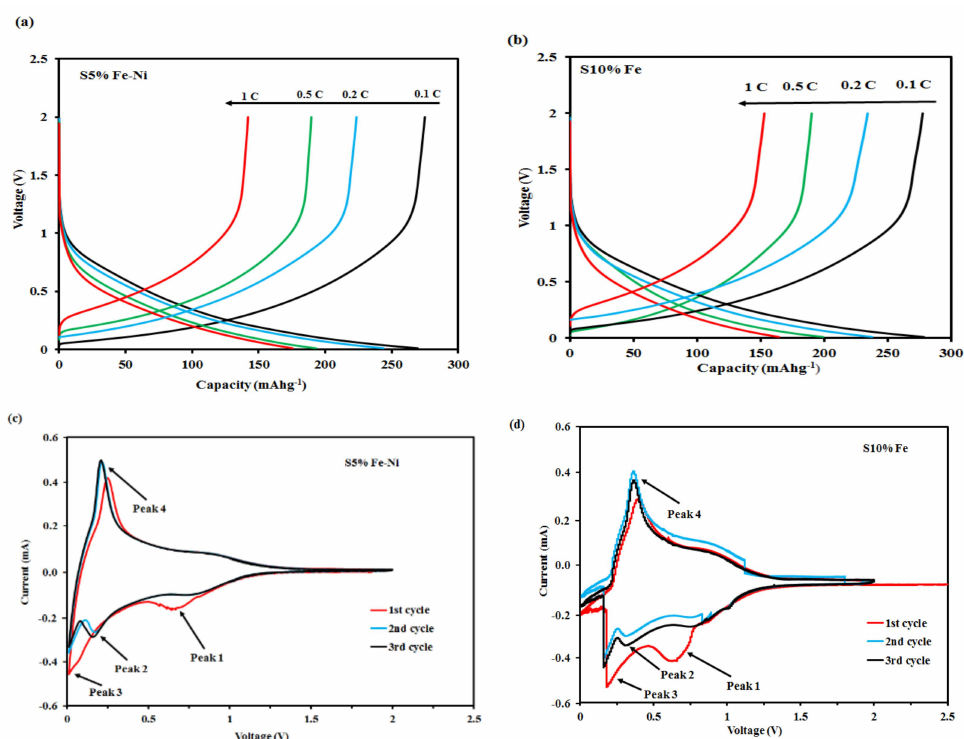
Figure 5. Electrochemical performances of the FLG materials: ( a , b ) GCD curves of the S5% Fe-Ni and S10% Fe samples at rates of 0.1 to 1 C; ( c , d ) CV curves of the S5% Fe-Ni and S10% Fe samples at a scan rate of 0.1 mVs − 1